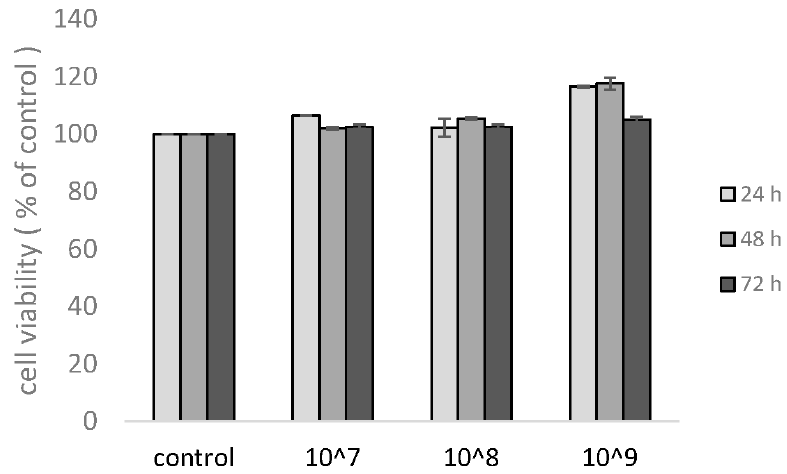
Figure 2. Effect of different doses of UCMSC-EVs on the viability of KU812 cells. Cells were incu- bated with different concentrations of extracellular vesicles for the indicated times. The number of KU812 cells was measured by trypan blue exclusion method. The results show the fold change rel- ative to the control. Data represent the mean ± SD of three independent experiments.